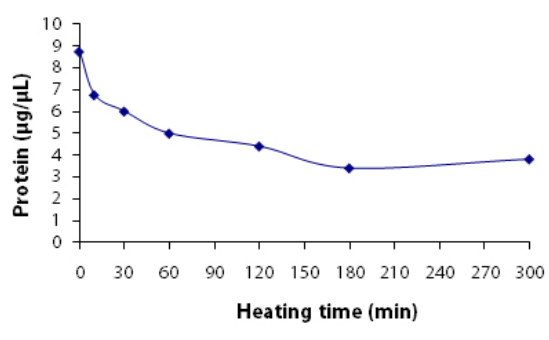
Figure 1 . Protein content of the supernatant obtained from heated cobra venom. Naja naja venom was first heated at 100°C for 10, 30, 60, 120, 180 or 300 minutes, and then centrifuged at 15,000 g/minute for 30 minutes. The supernatant protein content (µg/µL) of each portion was determined by the colorimetric method of Bradford